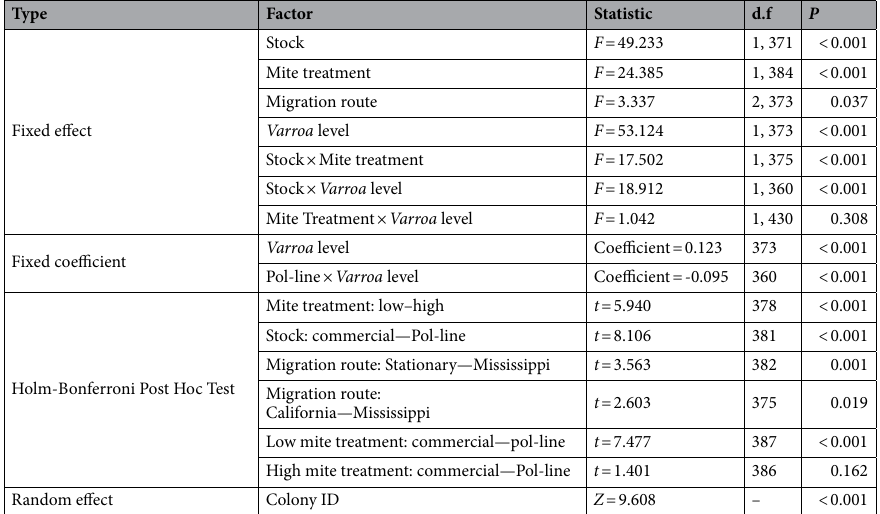
Table 1. Summary statistics for GLMM assessing the effect of Varroa levels on colony survival. Symbols INDICATE factor interactions (×), pairwise comparisons (−), and groupings (:), d.f. are calculated via the Welch–Satterthwaite approximation.